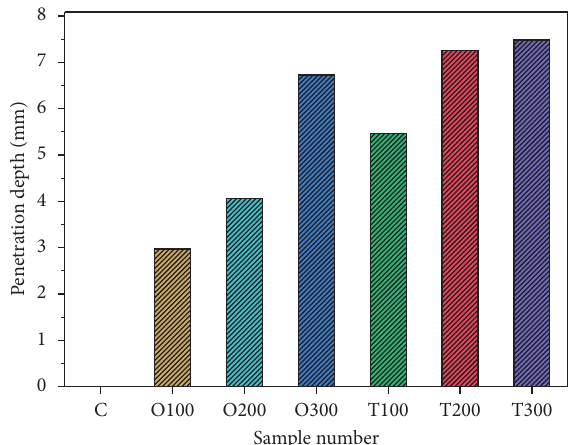
Figure 9: Penetration depth of silane into